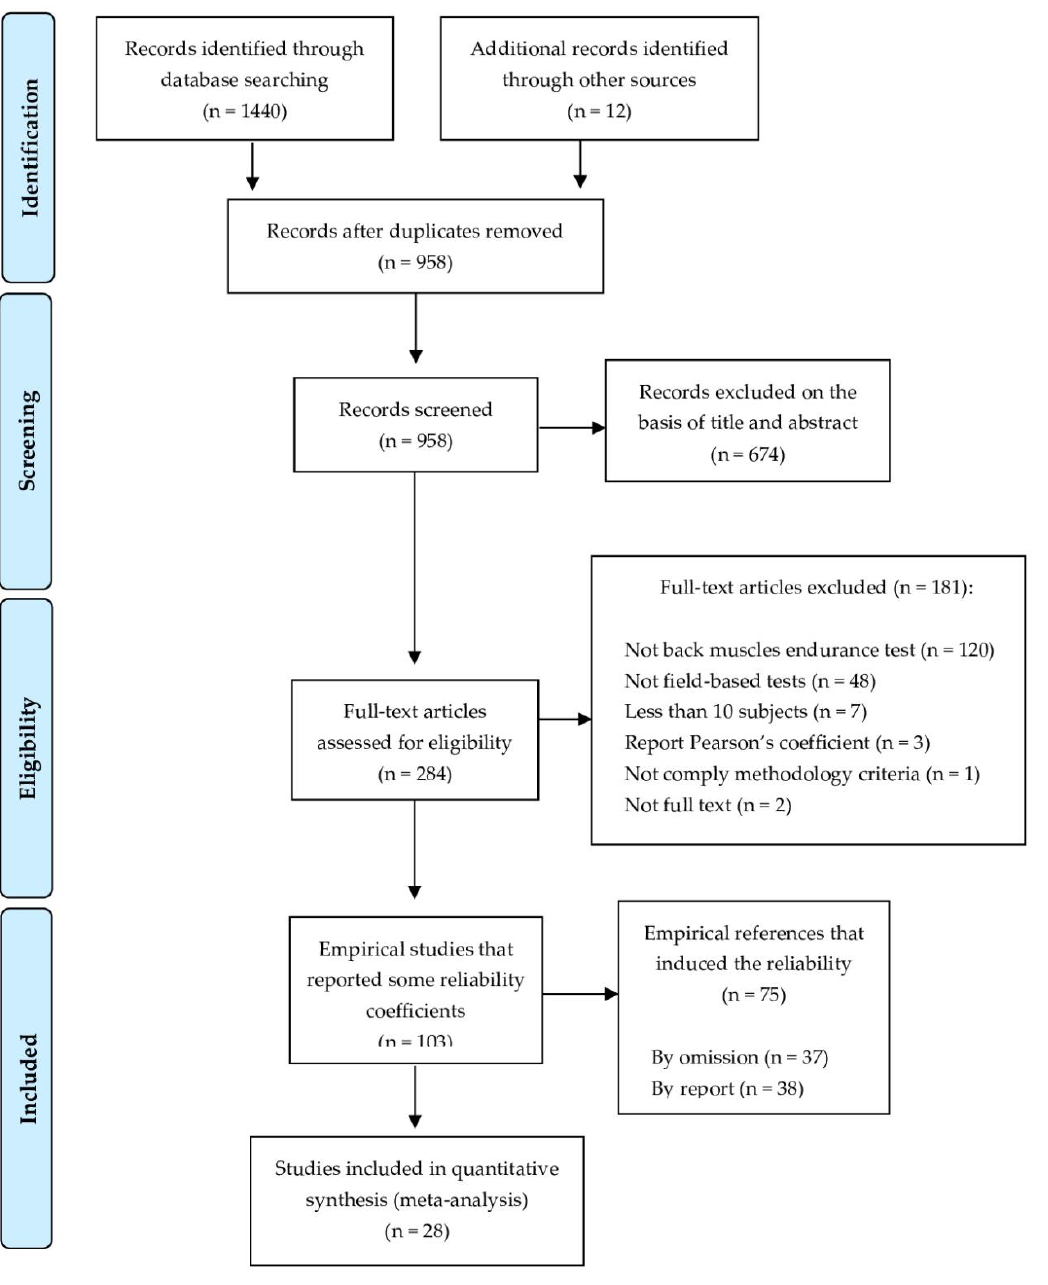
Figure 1. The Preferred Reporting Items for Systematic Reviews and Meta-Analyses (PRISMA) flow diagram of the literature search.